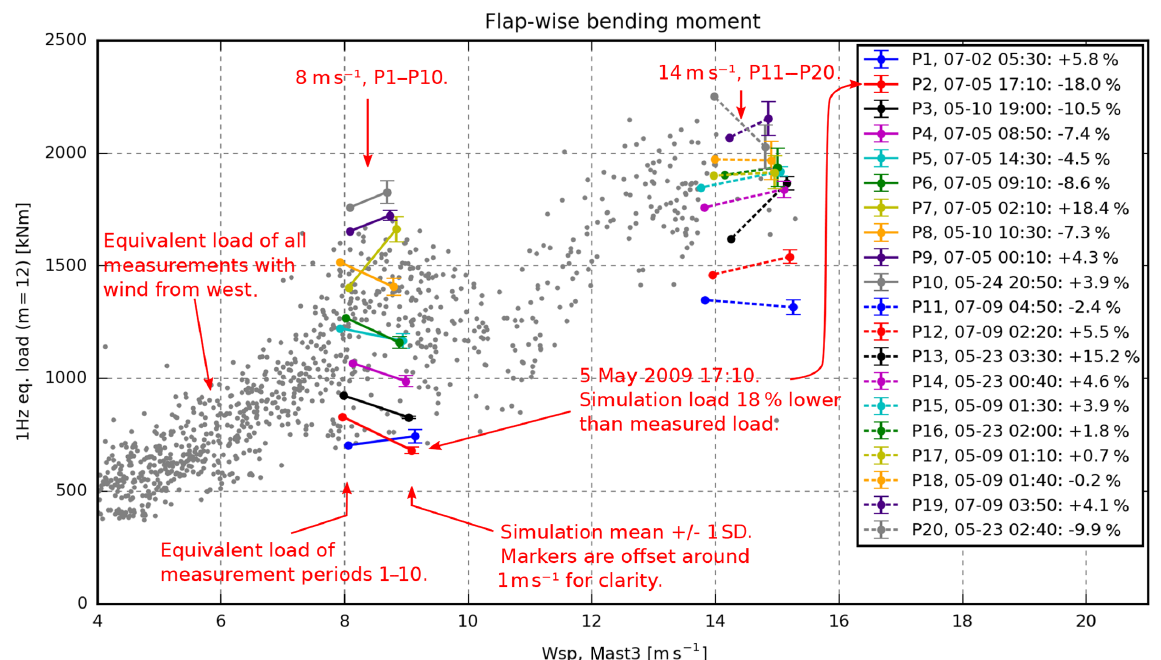
Figure 13. A schematic overview showing how to interpret Figs. 14–17. The figure shows the equivalent flap-wise bending moment of blade A. The grey dots represent the equivalent loads of all measurements with wind from the west, i.e. no-wake situations. The 20 selected periods, P1–P10 at 8ms − 1 and P11–P20 at 14ms − 1 , are illustrated by dots connected to error bars. The dots show the measured equivalent load and wind speed, whereas the error bars illustrate the simulated mean loads ± 1 σ . Note that the error bars are offset around 1ms − 1 to the right for clarity. The red dot and error bar, for instance, represent P2, i.e. 7 May 2019, 17:10–17:20LT. The equivalent load measured in this period was around 830kNm, whereas the six corresponding simulations had a mean load level around 682kNm and a standard deviation of